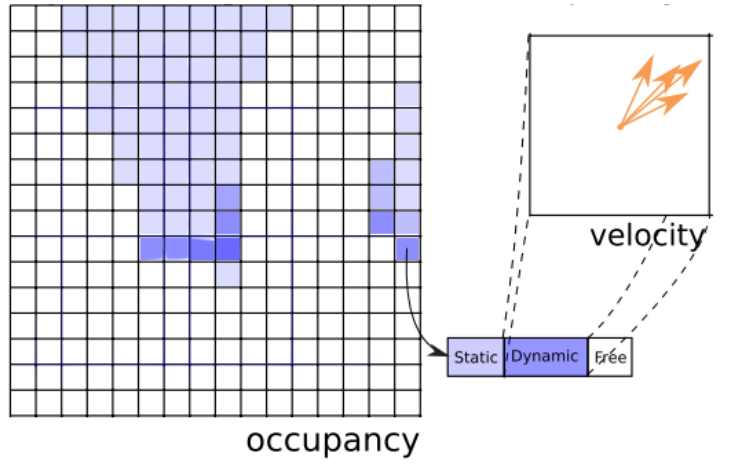
Figure 7. Proposed representation in Hybrid Sampling Bayesian Occupancy Filter (HSBOF) [13]: a two-dimensional grid, to each cell we assigned an occupancy value, a static coefficient P ( V = 0 ) and a set of particles drawn along P ( V = v | V (cid:54) = 0 ) . Reproduced with permission from reference [13]. Copyright 2014